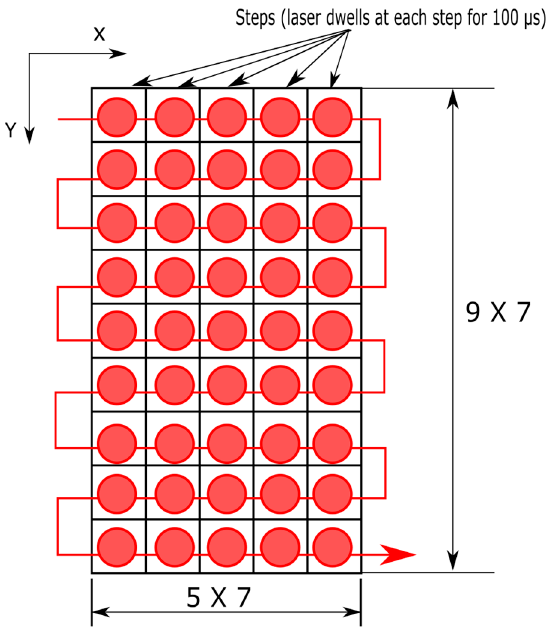
Figure 6. Schematic of the beam scan module (BSM) scanning movement.